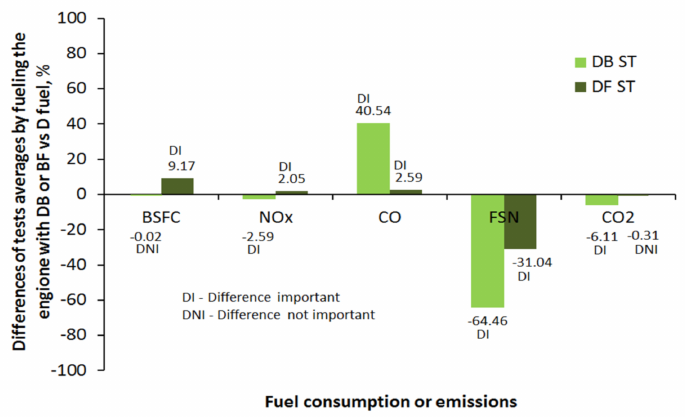
Figure 11. Differences in ESC test results by feeding the investigated engine with both mixtures in comparison to feeding with standard diesel fuel.